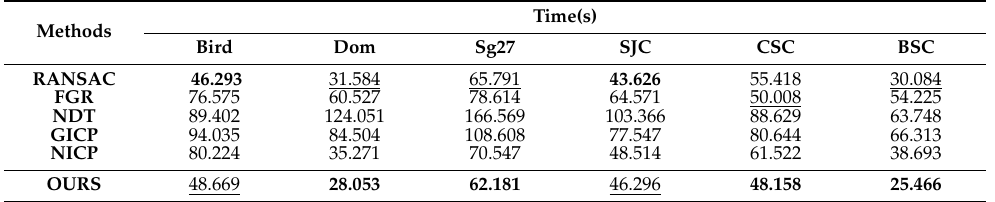
Table 5. Time consumption comparison. Various methods are used sequentially to register selected samples, record the respective time, and analyze the results. (There is an indication of the best performance in bold, while there is an indication of the second-best performance in